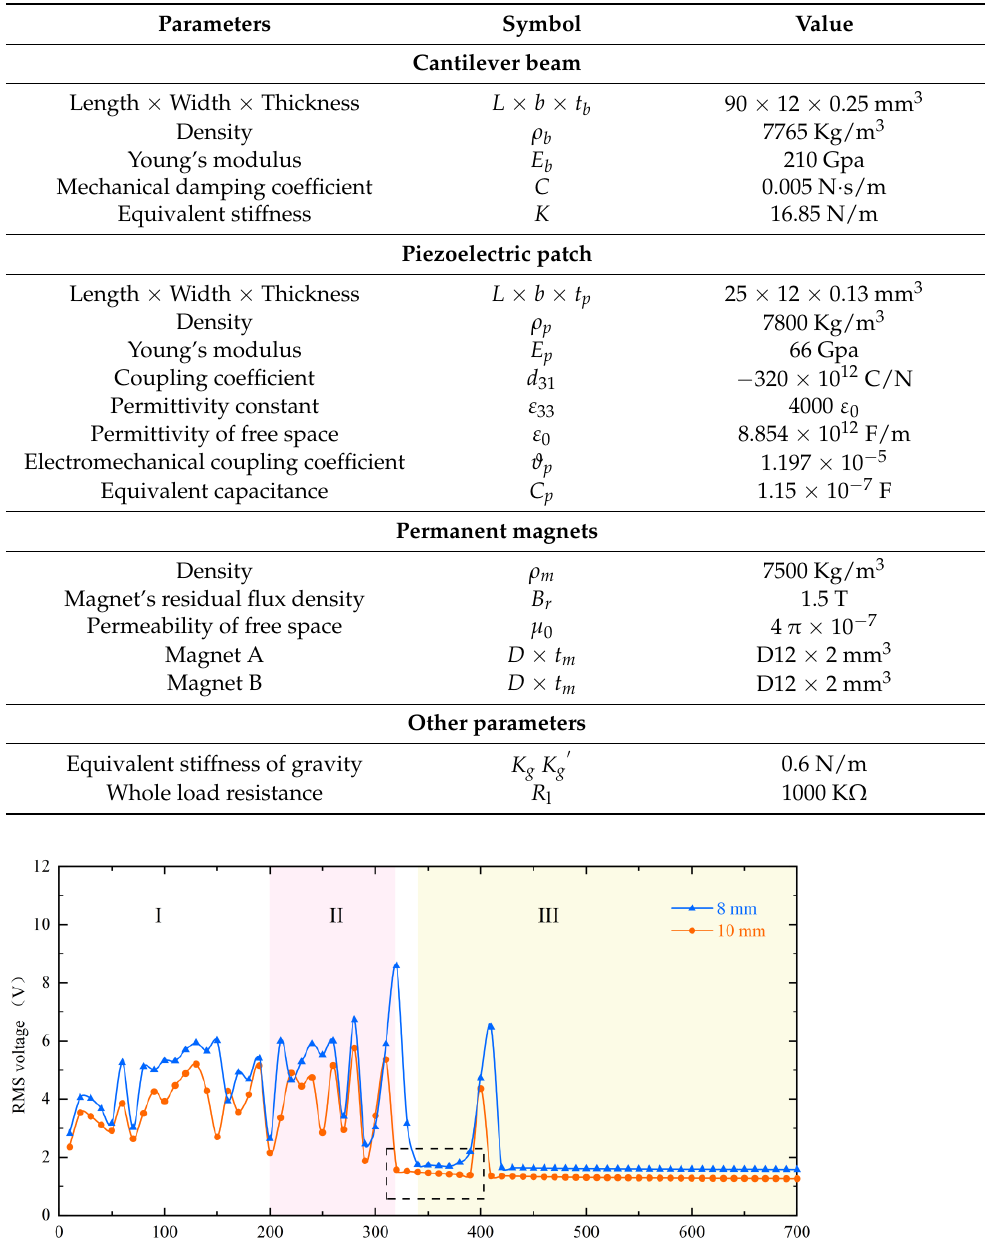
Table 1. Parameters of the piezoelectric energy harvester configuration.